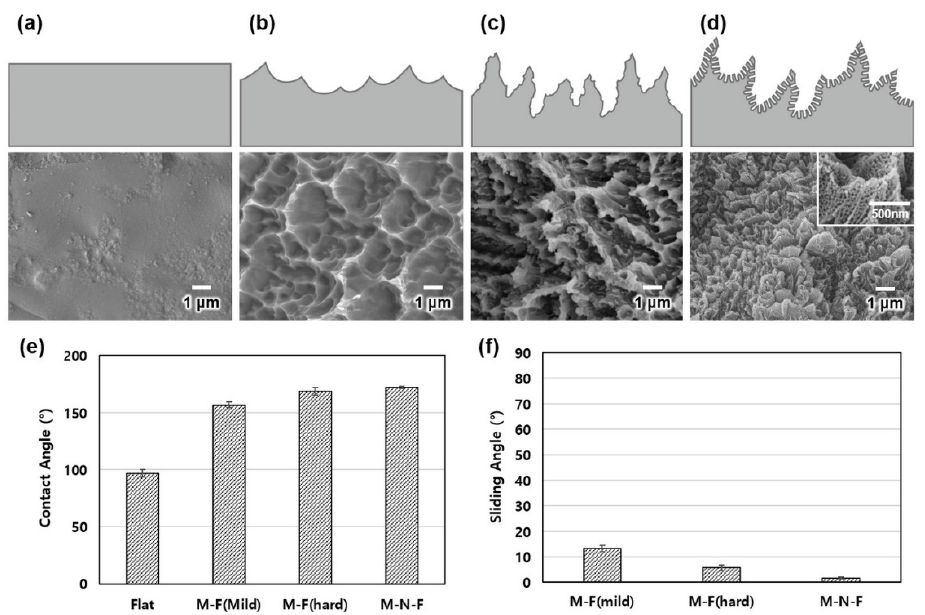
Figure 2. Cross-sectional diagrams and SEM images of the ( a ) original Ti, ( b ) mild-etched Ti M-F, ( c ) hard-etched Ti M-F, and ( d ) Ti M-N-F surfaces. ( e ) Contact and ( f ) sliding angles for the different Ti surfaces.